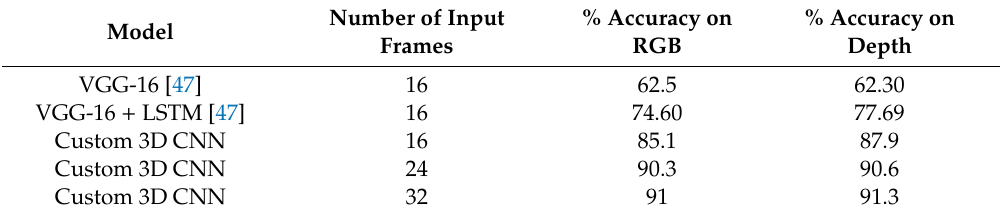
Table 4. Improvement of the custom 3D CNN by increasing the input size and comparison to state-of-the-art techniques applied on the EgoGesture dataset [45].